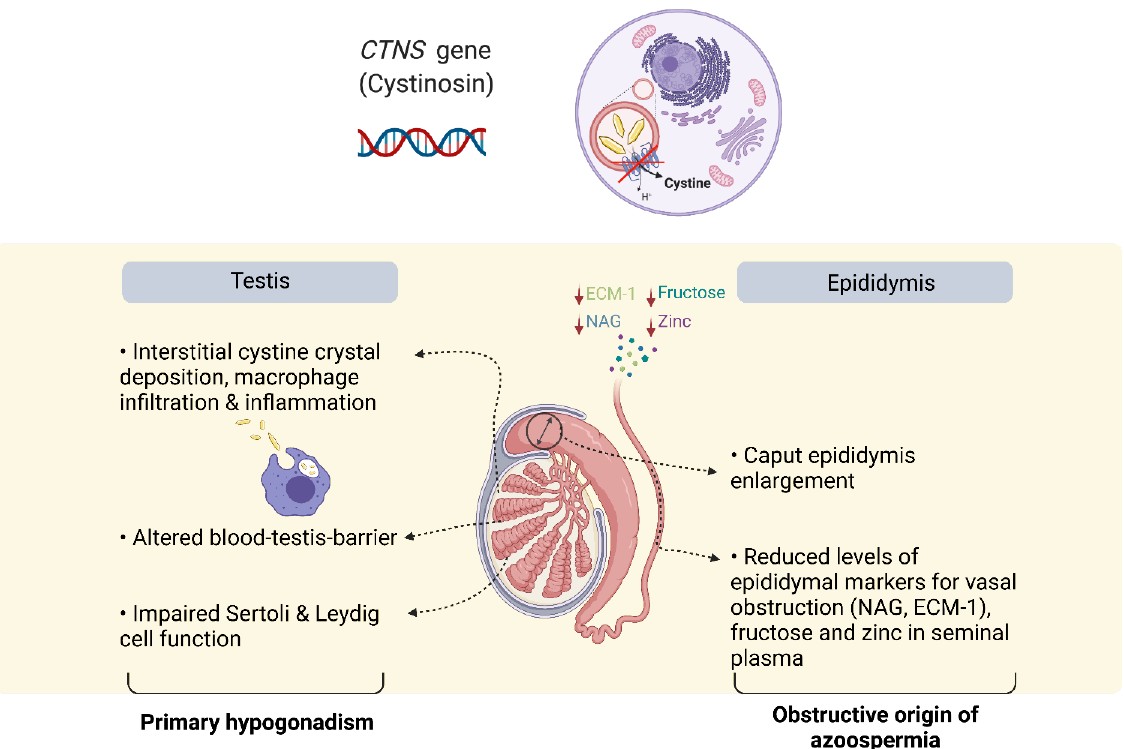
Figure 2. Plausible mechanism of infertility in male infantile cystinosis patients. Bi-allelic mutations in the CTNS gene lead to accumulation of cystine in the lysosomes, cell apoptosis, phagocytosis of cell debris and cystine crystals, and inflammation. In kidneys, it is known to be associated with an increased shedding of epithelial cells. In infantile type male cystinosis cystinosis patients, an enlarged caput epididymis, and reduction in seminal plasma markers, including zinc, fructose, extracellular matrix protein-1 (ECM-1) and neutral α glucosidase (NAG), point towards obstruction of the male genital tract as the primary cause for azoospermia. In parallel, cystine accumulation and macrophage infiltration results in interstitial inflammation in the testis, which is associated with alterations at the blood–testis barrier, and Sertoli and Leydig cell impairment, leading to a progressive primary hypogonadism.